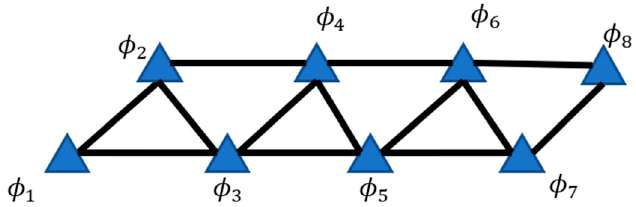
Figure A1. The 2-connection triangulation network. φ 1 , φ 2 · · · , φ 8 are the SLC phase acquired at time t 1 , t 2 · · · , t N .